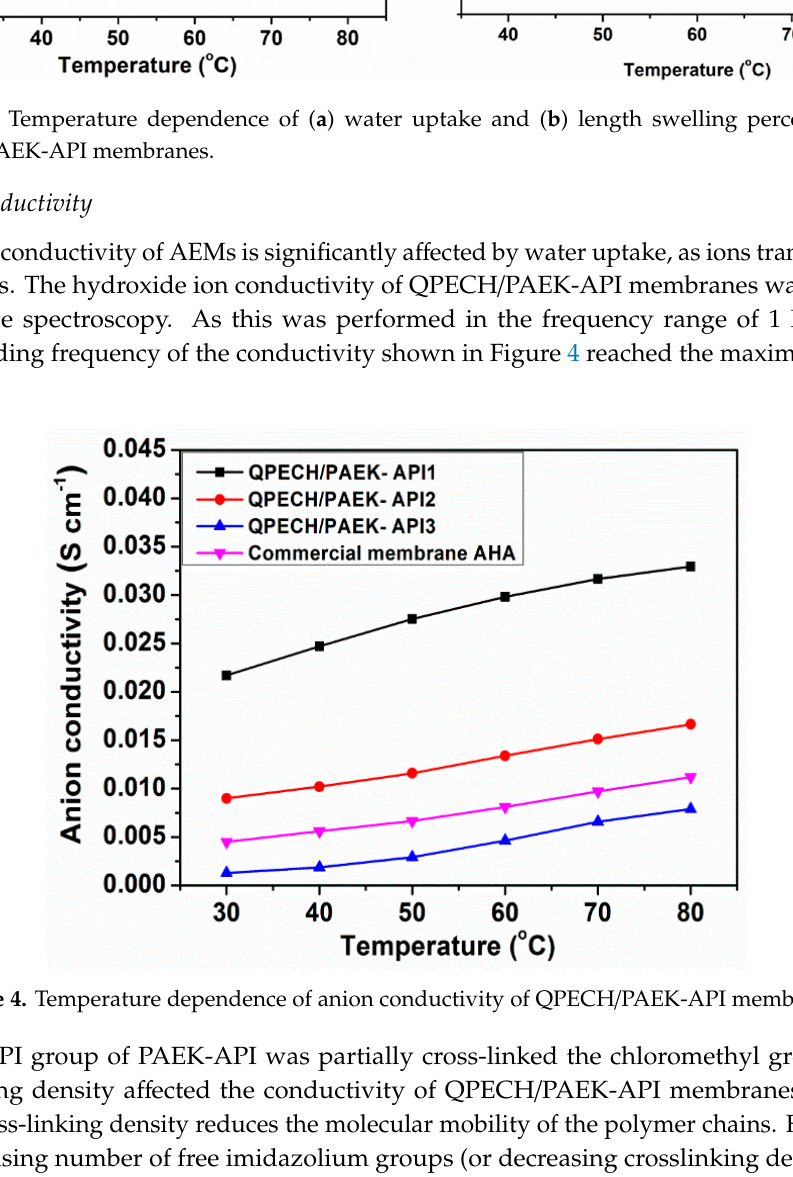
Table 2. The real and imaginary parts of the bulk resistance of membranes at different temperature.